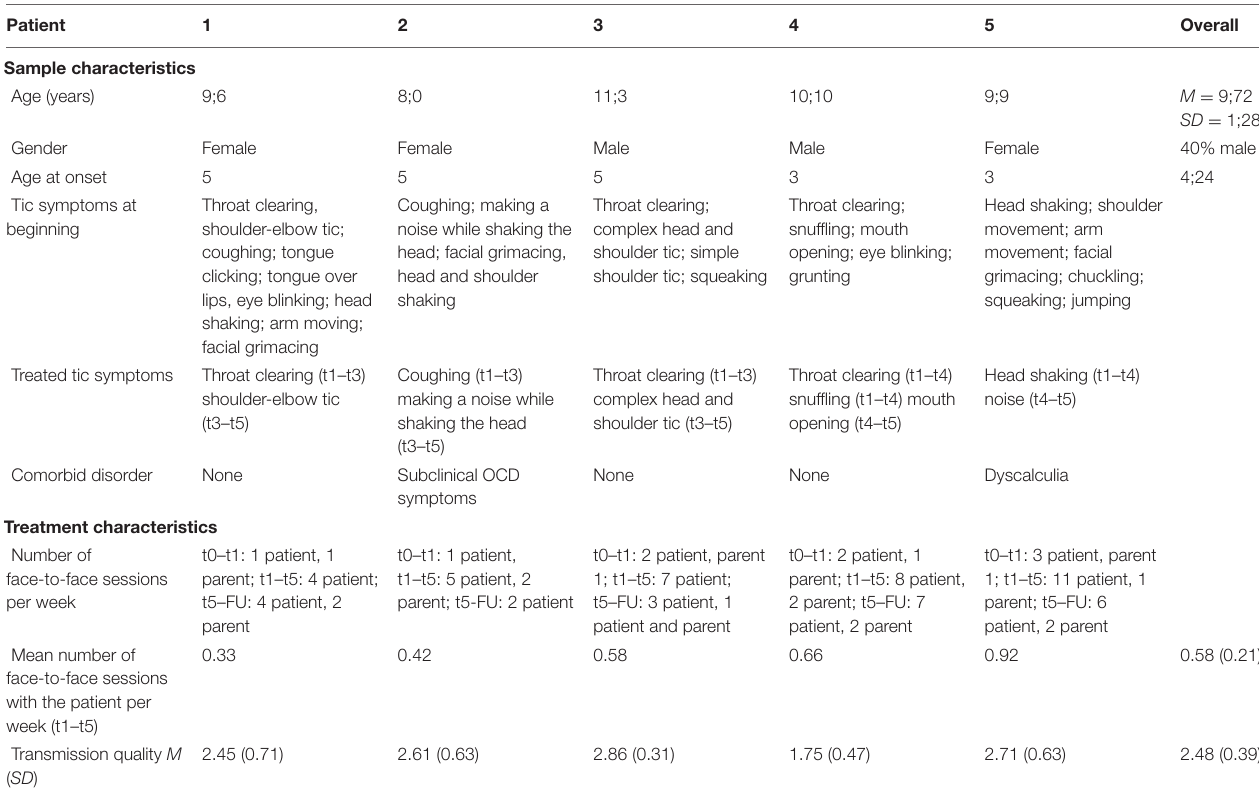
TABLE 1 | Sample and treatment